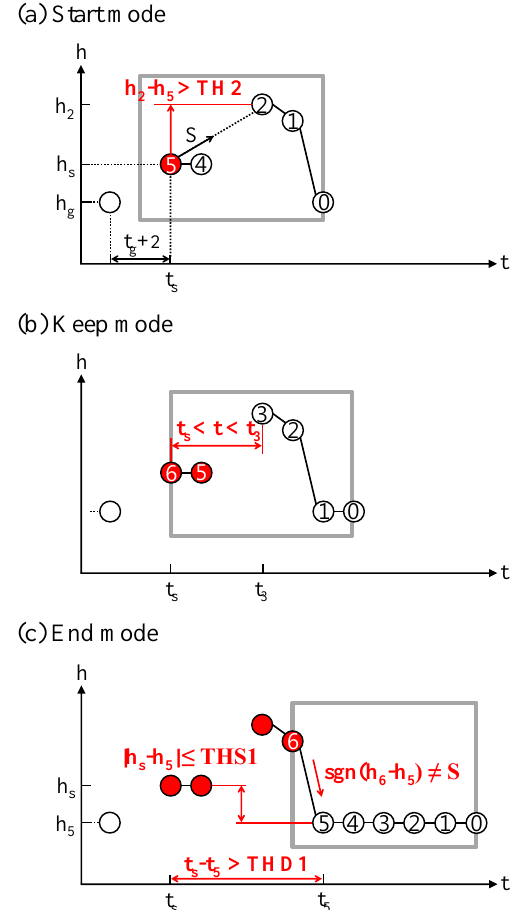
Figure 4: Schematic sketch of each mode of the outlier removal algorithm: (a) start mode, (b) keep mode, (c) end mode. The water-level data are represented as circles and Figure 4. Schematic sketch of each mode of the outlier removal al- a gray box indicates the moving window. Red circles indicate detected outliers and gorithm: (a) start mode, (b) keep mode, (c) end mode. The water conditions are written in red. level data are represented as circles, and a gray box indicates the moving window. Red circles indicate detected outliers, and condi- tions are written in